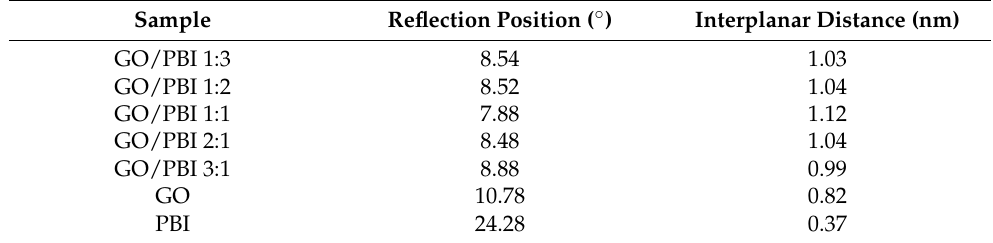
Figure 4. X-ray diffraction patterns of the GO/PBI X:Y composites, pure GO, and pure PBI membranes. Table 2. Interplanar distances of the GO/PBI X:Y composite, pure GO, and pure PBI membranes.